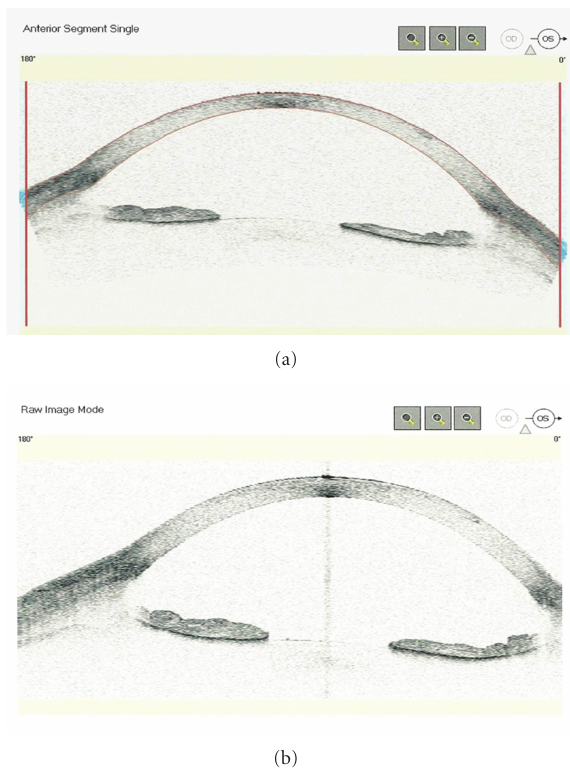
Figure 7: AS-OCT: Raw and anterior segment single mode images of preblinking (a) in an eye with pigment dispersion syndrome; postblinking image (b) shows increased iris concavity, deeper anterior chamber, and a wider angle from increased iridolenticular contact as a result of blinking.